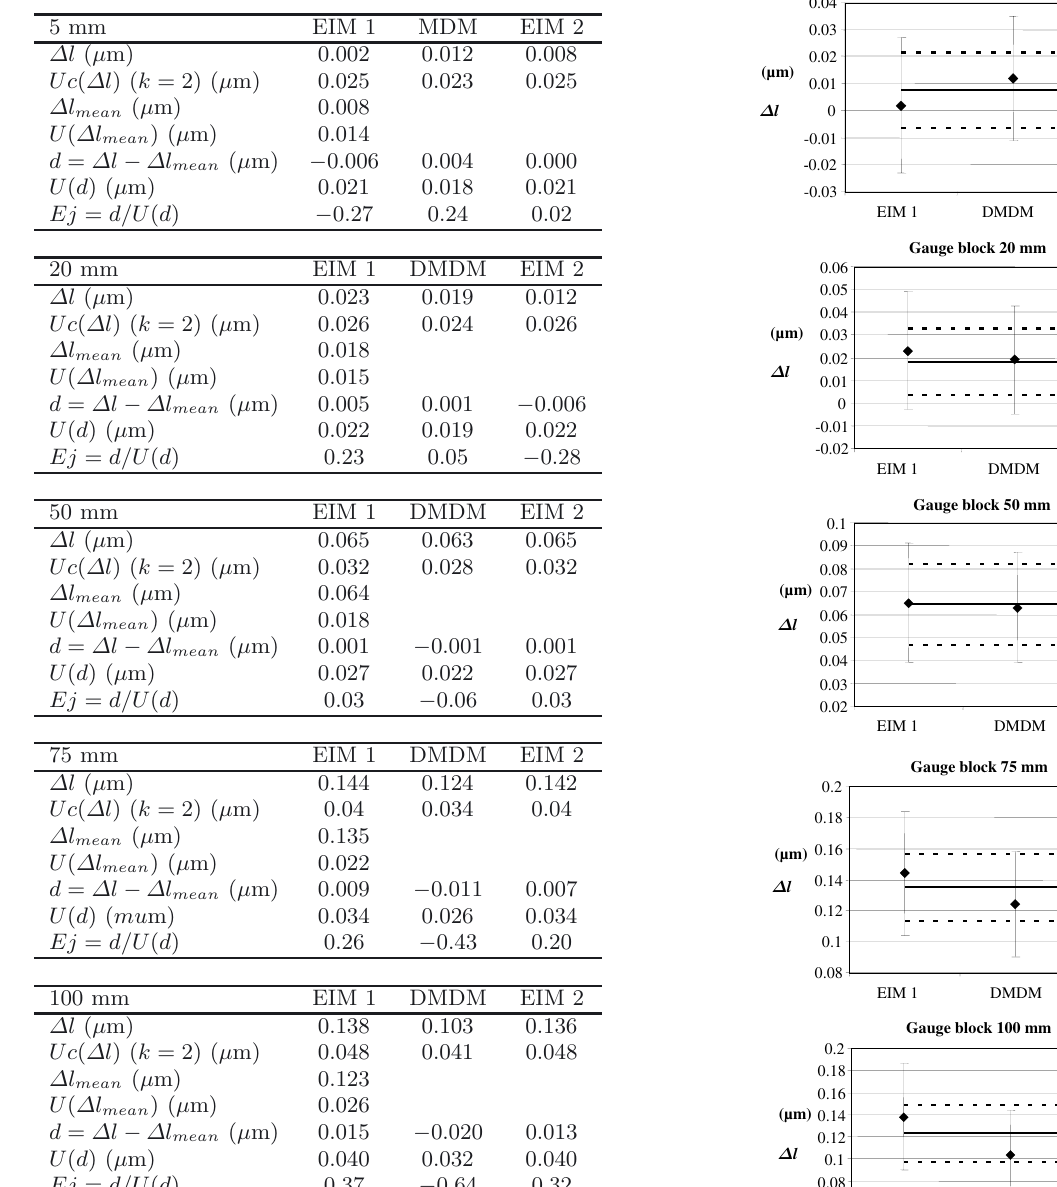
Table 2. Results of the comparison.